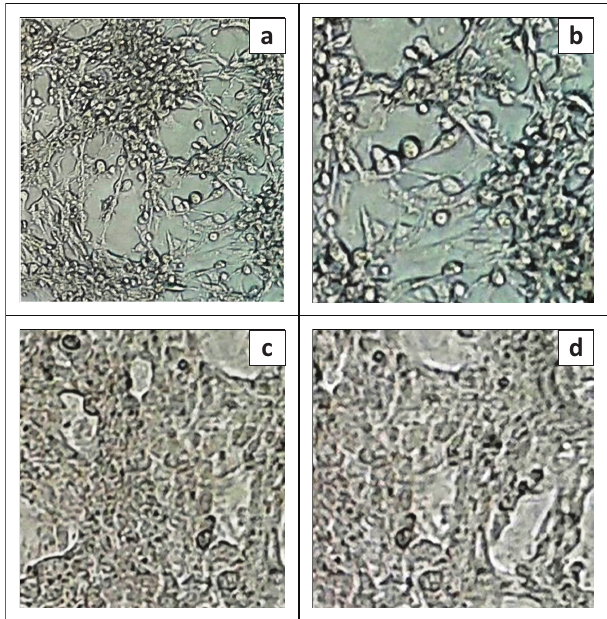
FIGURE 3: Microscopic examination of the Vero cells for evidence of viral cytopathic effects in virus neutralisation assay. (a and b) The CPEs in the cells treated with the sera collected from control groups for pcDNA3.1 and PBS, respectively; (c and d) the cells treated with the sera collected from the groups immunised with pcDNA3.1-G1 and bovine ephemeral fever (BEF)-inactivated vaccine, respectively.